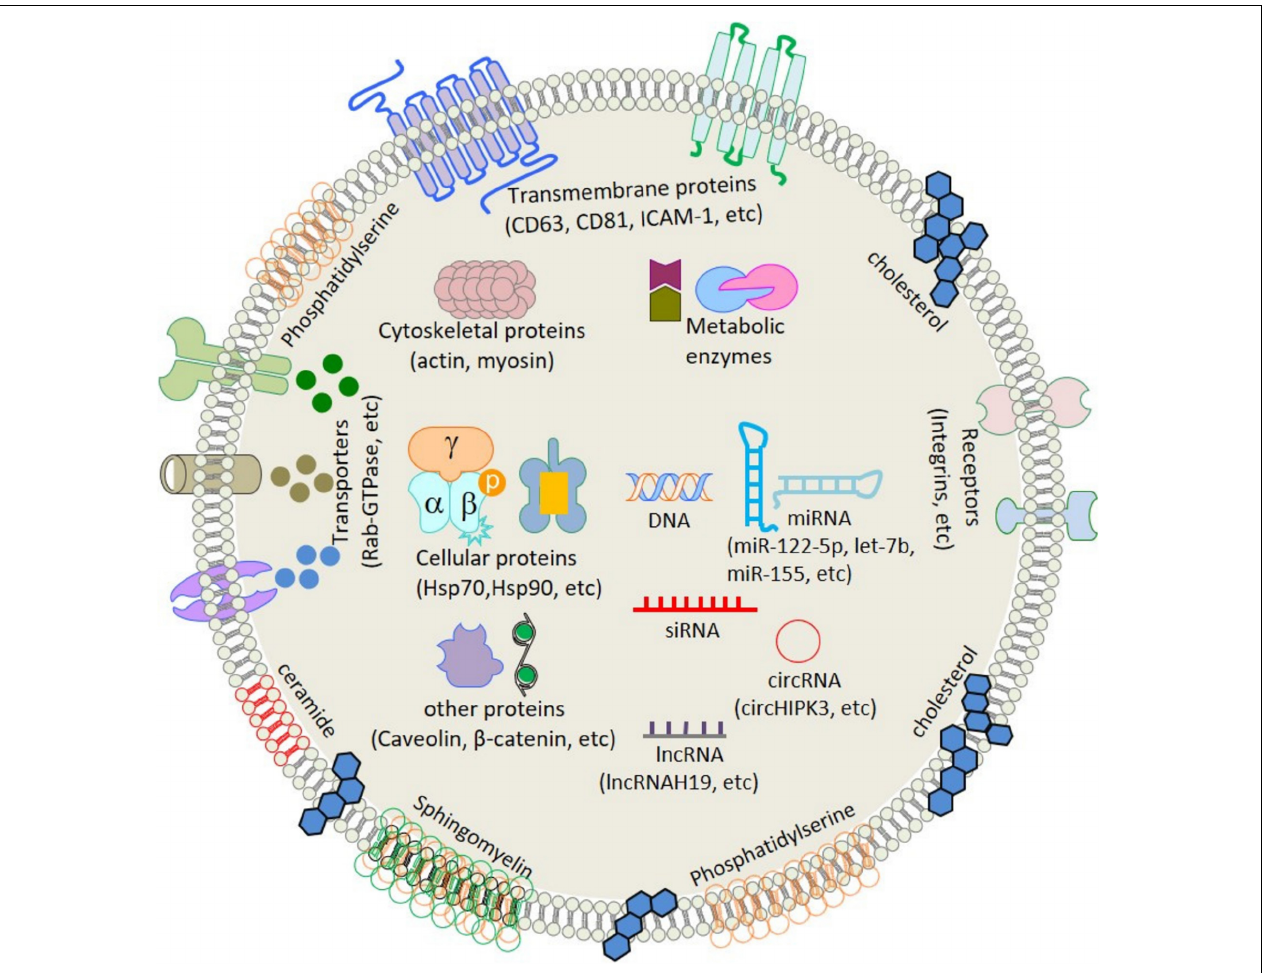
FIGURE 1 | Schematic structure and contents of exosome. ATPase, adenosine triphosphatase; CD, cluster of differentiation; GAPDH, glyceraldehyde 3-phosphate dehydrogenase; HSP, heat shock protein; ICAM-1, intercellular adhesion molecule-1; LAM 1/2, lysosomal-associated membrane protein 1/2; MHC, major histocompatibility complex; miRNA, microRNA; mRNA, messenger RNA; MVB, multivesicular body; PGRL, PG regulatory-like protein; pgk1, phosphoglycerate kinase 1. [Adopted from Jan et al. (2021) distributed under the Creative Commons Attribution